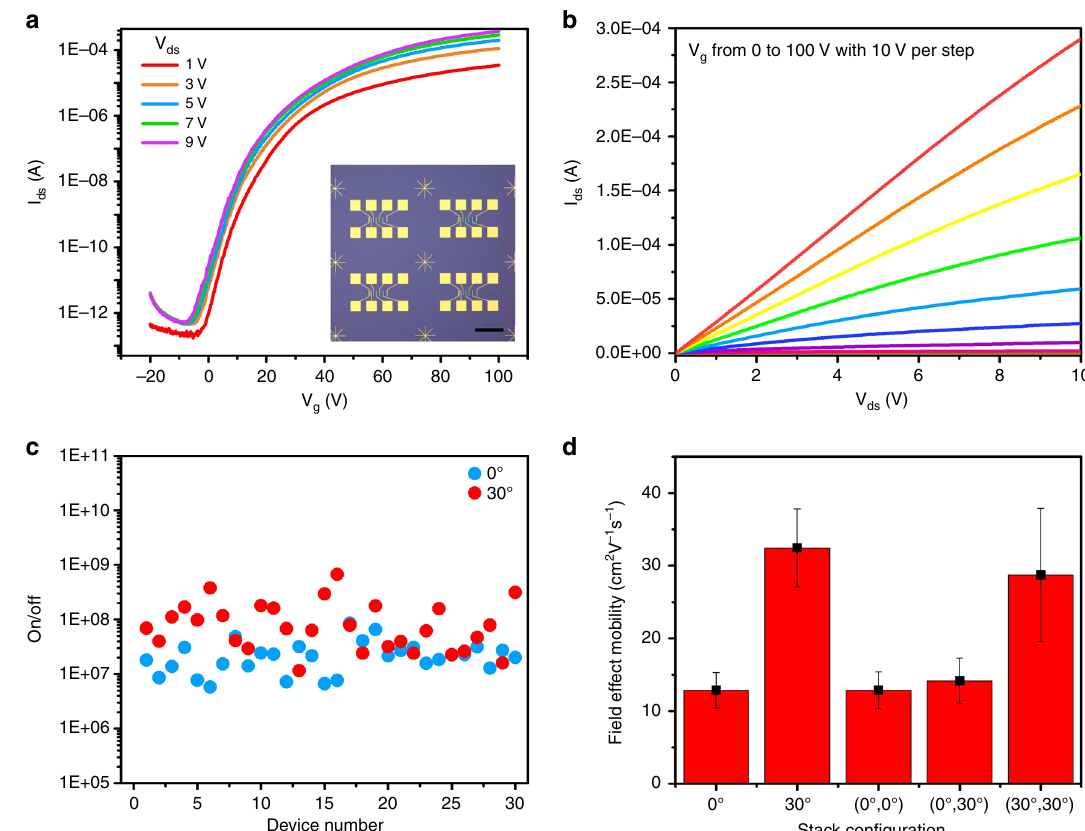
Fig. 5 Electrical properties of twisted multilayer MoS 2 fi lms. a Electrical transfer curves of a typical 30° twisted bilayer MoS 2 FET, inset is an optical image of a device array, scale bar 400 μ m. b Electrical output curves of a typical 30° twisted bilayer MoS 2 FET. c On/off ratio of 0° and 30° devices. d Mobility statistics of twisted multilayer MoS 2 fi lms, error bars are Standard Deviations. Source data are provided as a Source Data fi